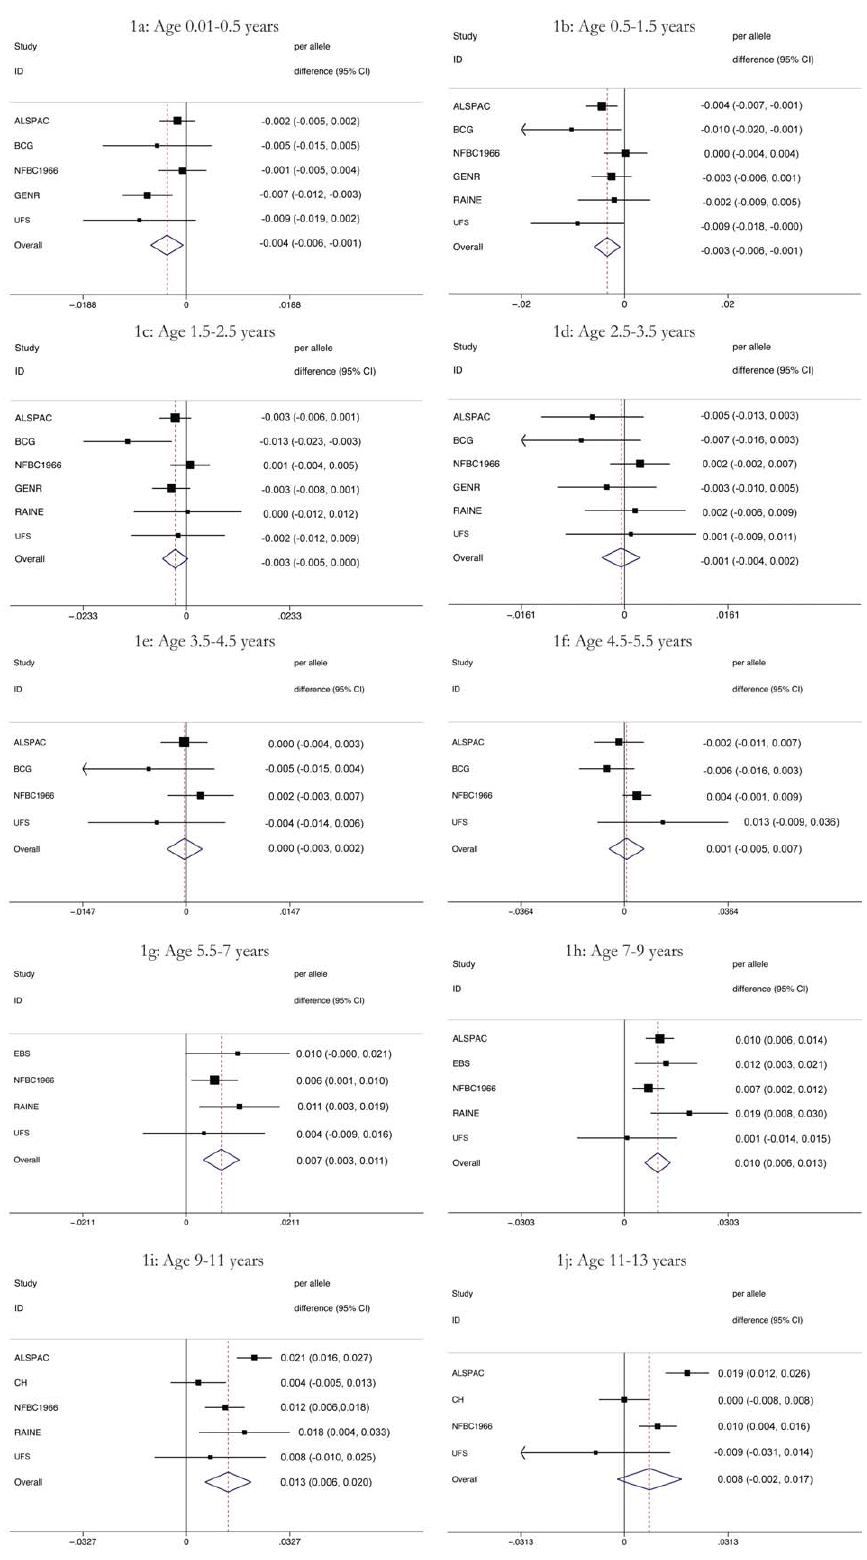
Figure 1. Results of the meta-analyses of the association between each additional minor allele (A) at rs9939609 and BMI by age (1a–1j). Figures are shown in units of lnBMI—to convert to percentages multiply by 100. Maximum heterogeneity in meta-analyses was I 2 81.7% (95% CI: 53, 93).